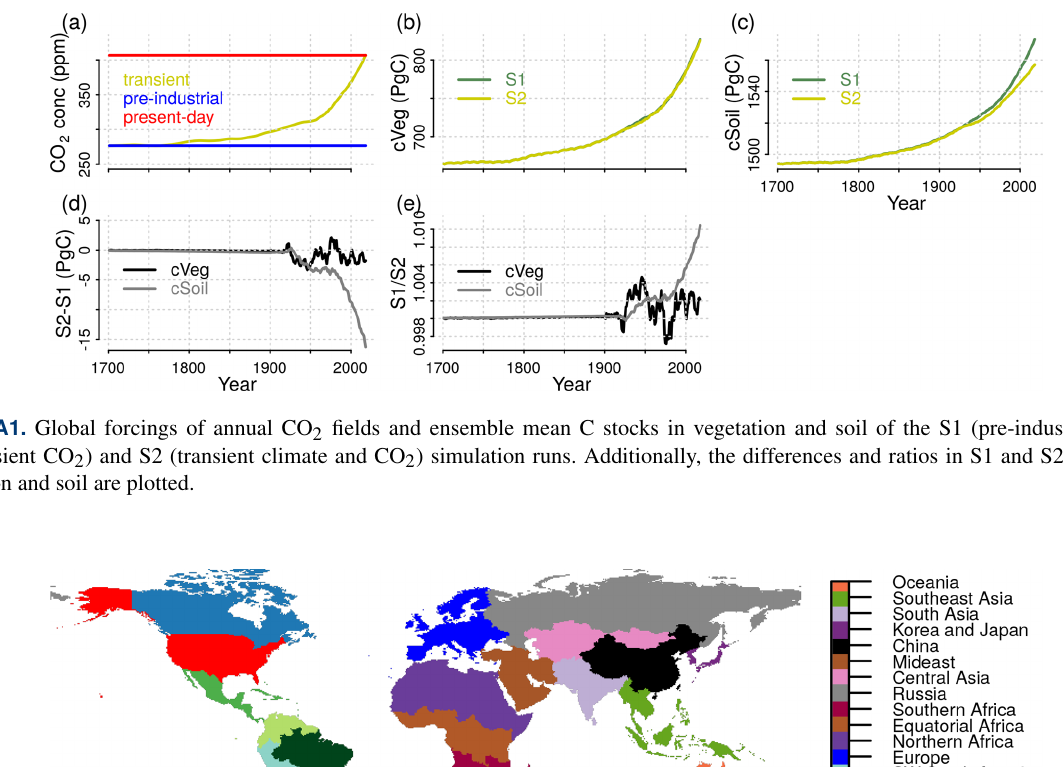
Earth Syst. Dynam., 12, 635–670, 2021